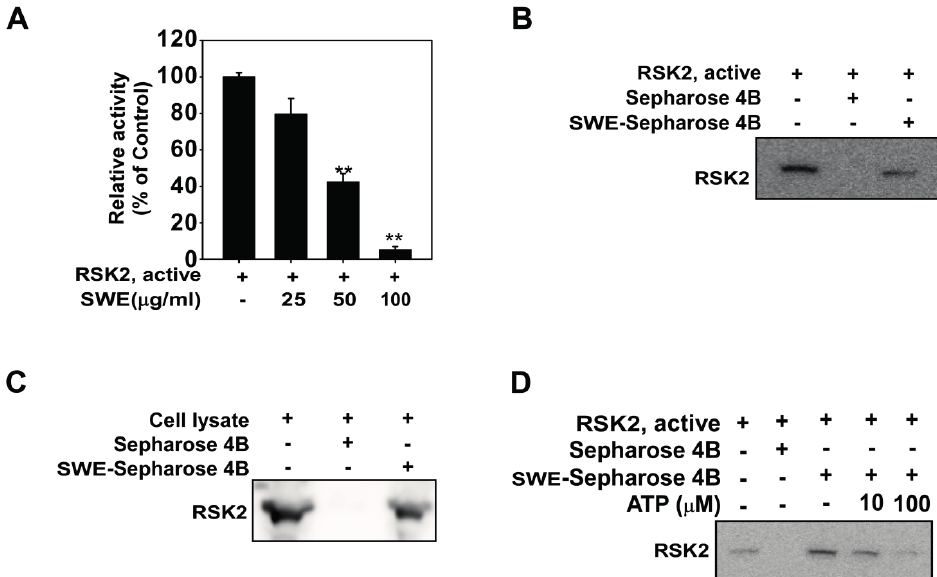
Figure 4 . Effects of SWE on ribosomal S6 kinase 2 (RSK2) activity with direct binding. ( A ) SWE inhibits RSK2 activity. Active RSK2 protein was incubated with SWE at